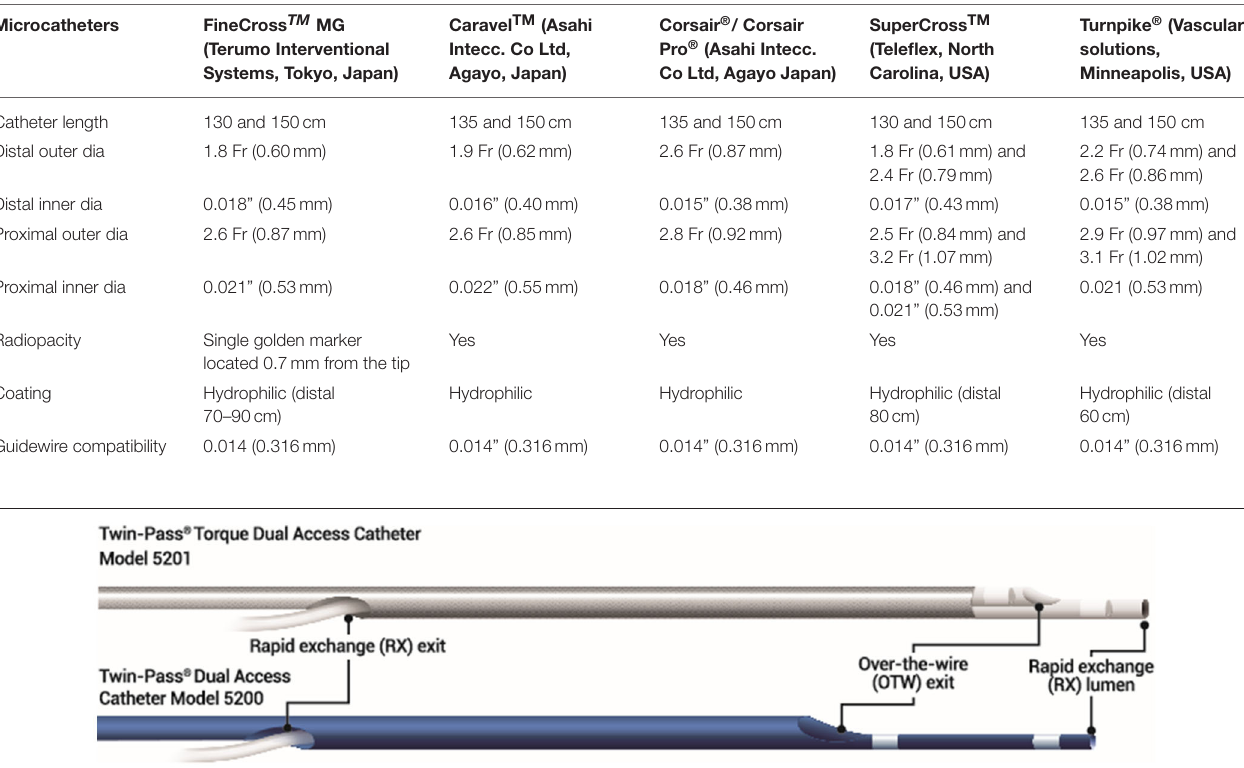
FIGURE 2 | Double-lumen microcatheter (DLM) (Twin-Pass Dual ® Access microcatheter)